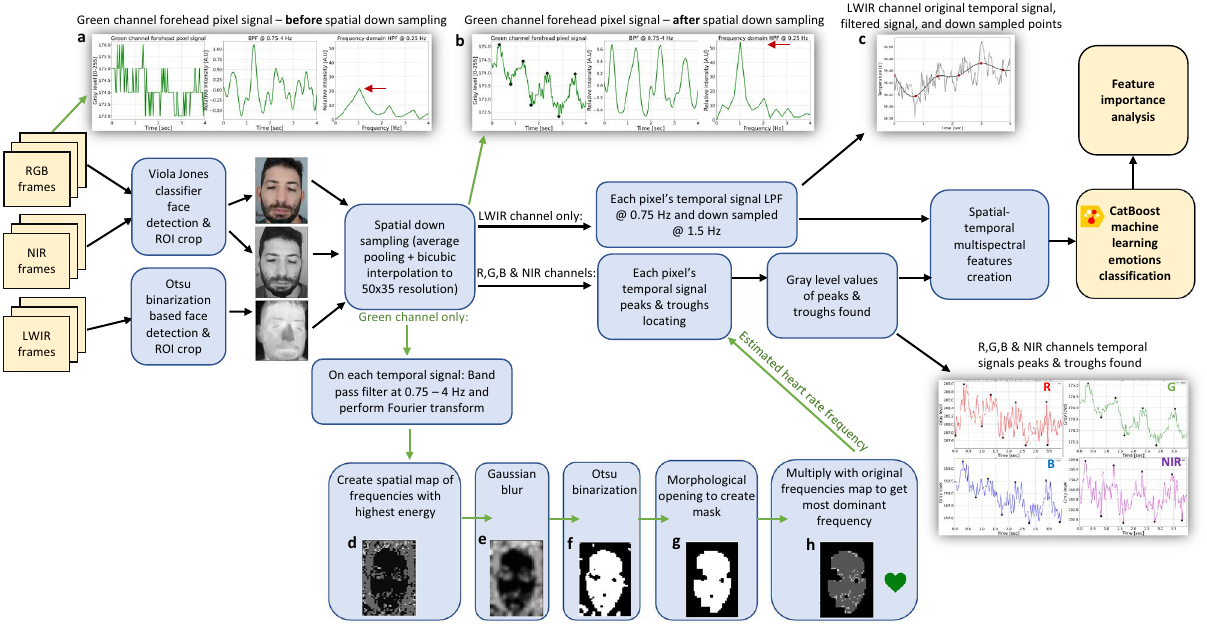
Figure 13. A diagram summarizing the proposed method. From left to right: input emotion-stimulated facial frames, face detection and cropping, spatial downsampling, heart rate estimation pipeline (bottom part, d–h), locating the RGB and NIR channels heart rate signals’ peaks and troughs (bottom right (R, G, B, NIR), downsampling the LWIR channel (upper right, c), and creating the TSTMS features from the face images at the peaks and troughs. The upper part is the green channel’s forehead pixel temporal signal example obtained at these stages, before (upper part, a) and after (upper part, b) spatial downsampling, as detailed in Fig.